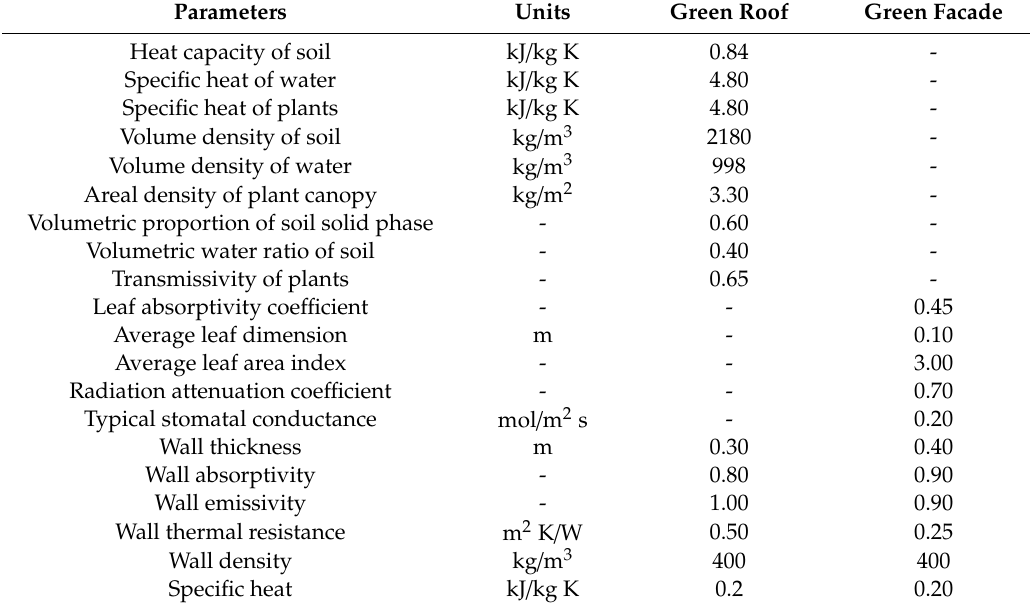
Table 2. Assumed values of plant and material parameters for the green roof and the green façade use cases. Parameters